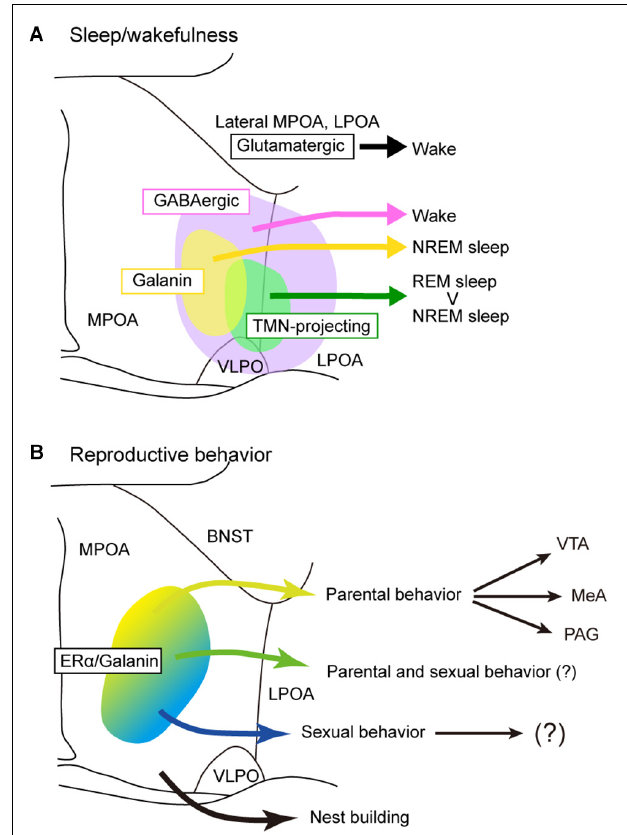
FIGURE 3 | Models of POA neuron groups that regulate sleep and reproductive behavior. (A) Different subgroups of POA GABAergic neurons control sleep and wakefulness differently. TMN-projecting GABAergic neurons promote NREM sleep and strongly REM sleep. Galanin-positive POA neurons that are mainly GABAergic generally promote NREM sleep. POA glutamatergic neurons promote wakefulness. (B) Estrogen receptor α and/or galanin-positive neurons in the MPOA regulate parental behavior and male sexual behavior. Neurons involving nest building behavior was not estrogen receptor α positive. BNST, bed nucleus of the stria terminalis; LPOA, lateral preoptic area; MeA, medial amygdala; MPOA, medial preoptic area; PAG, periaqueductal gray; TMN, tuberomammillary nucleus; VLPO, ventrolateral preoptic nucleus; VTA, ventral tegmental